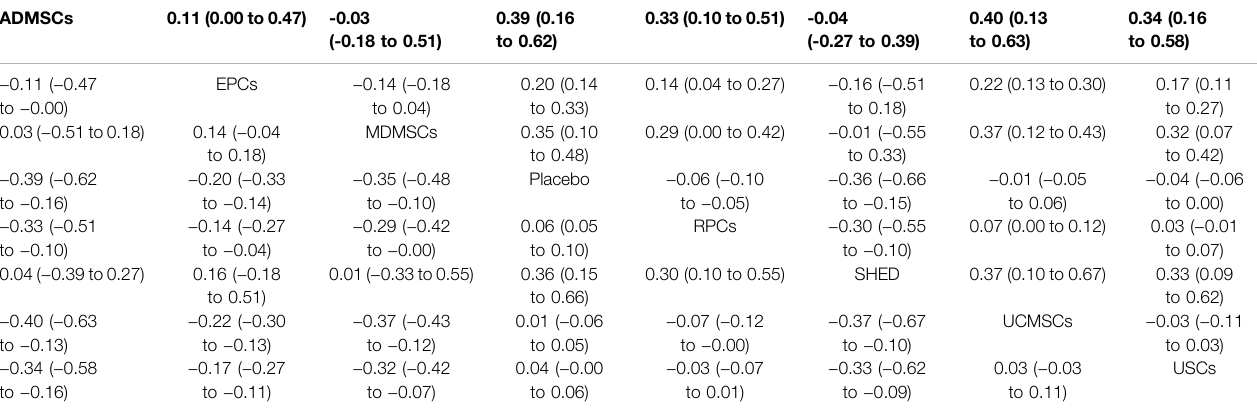
TABLE 4 | Network Meta-analysis results of serum creatinine levels in stem cell groups at 7 days after administration.